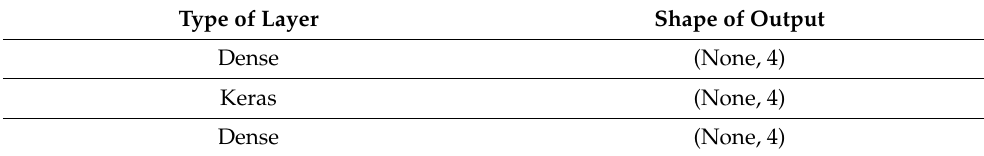
Table 3. Proposed model layered architecture.